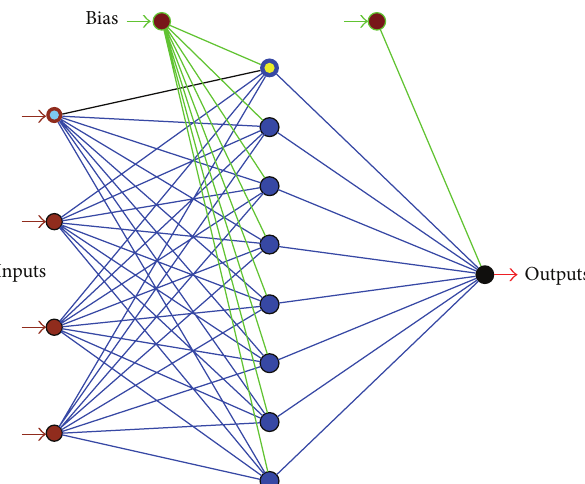
Figure 5: The structure of the photodegradation final model of QP- 4-8-1 that consists of 4 nodes in input layer, 8 nodes in hidden layer, and 1 node in output layer as